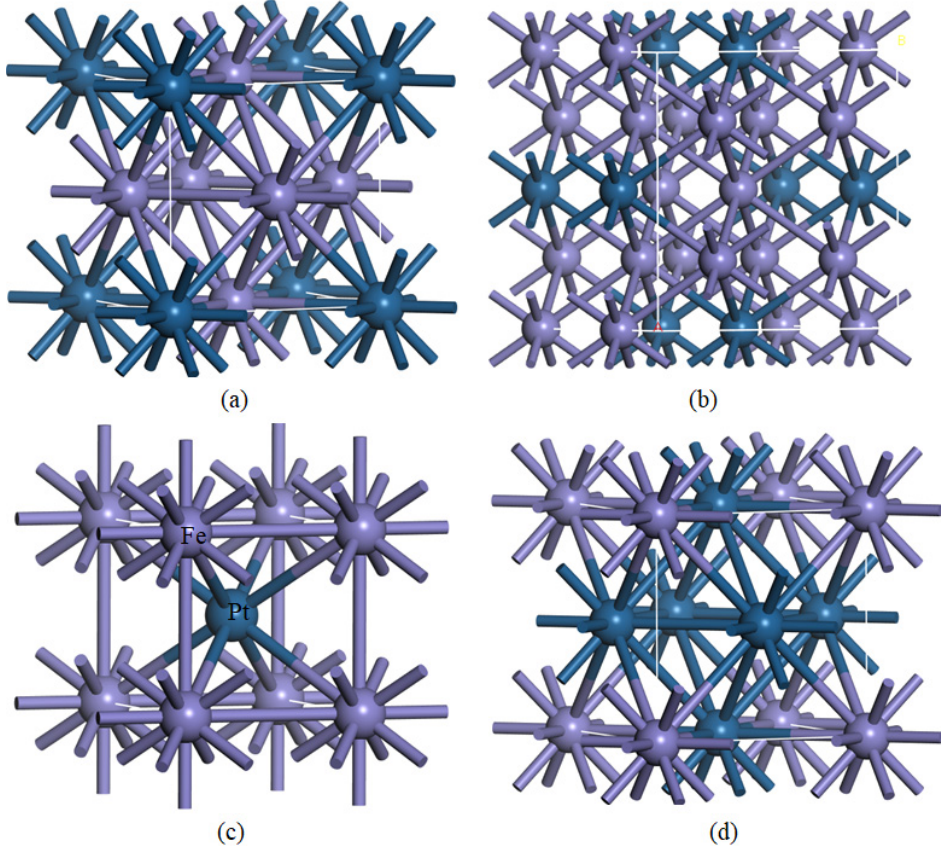
Figure 1. Structural coordination of ( a ) Pm-3m-Fe 3 Pt, ( b ) I4/mmm-Fe 3 Pt, ( c ) P4/mmm-FePt, and ( d ) Pm-3m-FePt 3 systems.